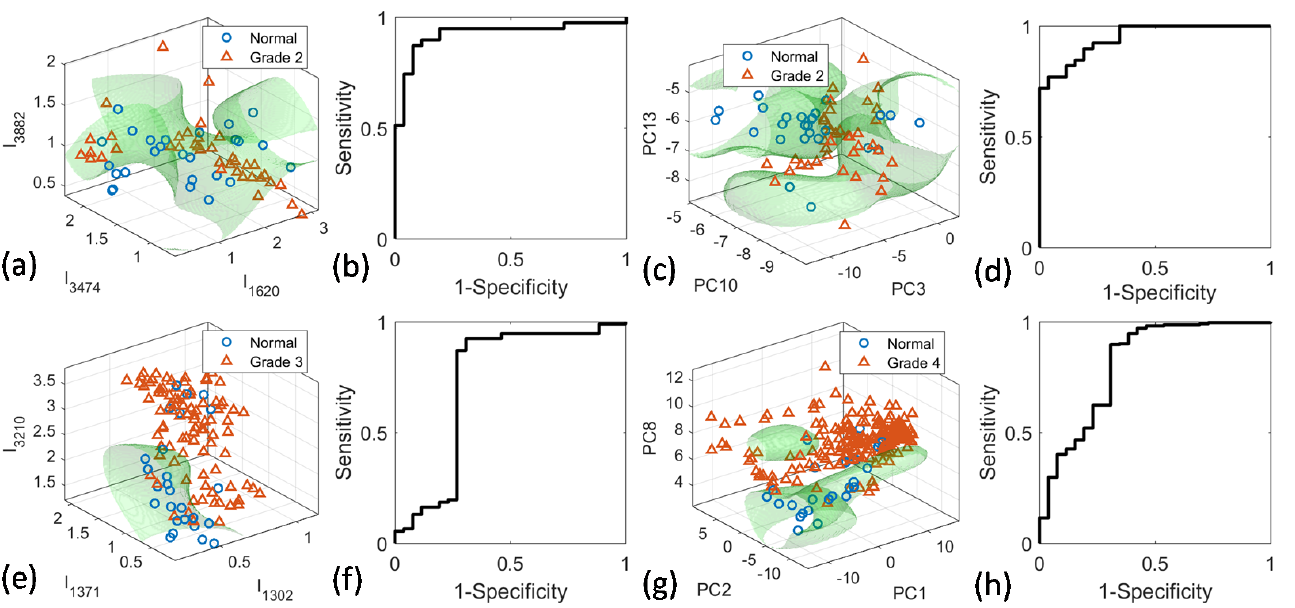
Figure 5. Binary classification of normal tissue and individual tumor grades using optimal combinations of peaks or PCs: ( a , c ) normal vs. grade 2 using peaks and PCs, respectively; ( e ) normal vs. grade 3 using peaks; ( g ) normal vs. grade 4 using PCs; ( b , d , f , h ) are the LOOCV ROC curves corresponding to ( a , c , e , g ), respectively.